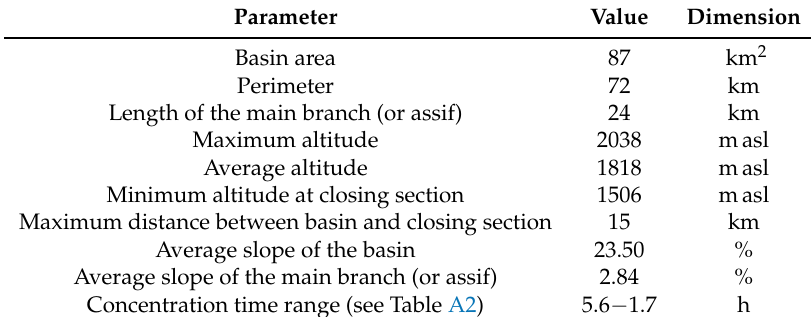
Table 1. Main characteristics of the study basin.